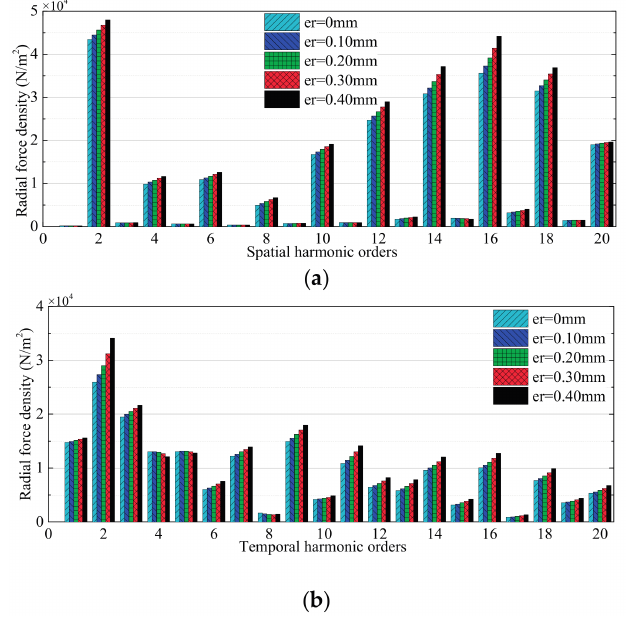
Figure 15. Harmonic contents of radial force density in the IPMSM with rotor deformation at high-speed load condition. ( a ) Spatial harmonics; ( b ) Temporal